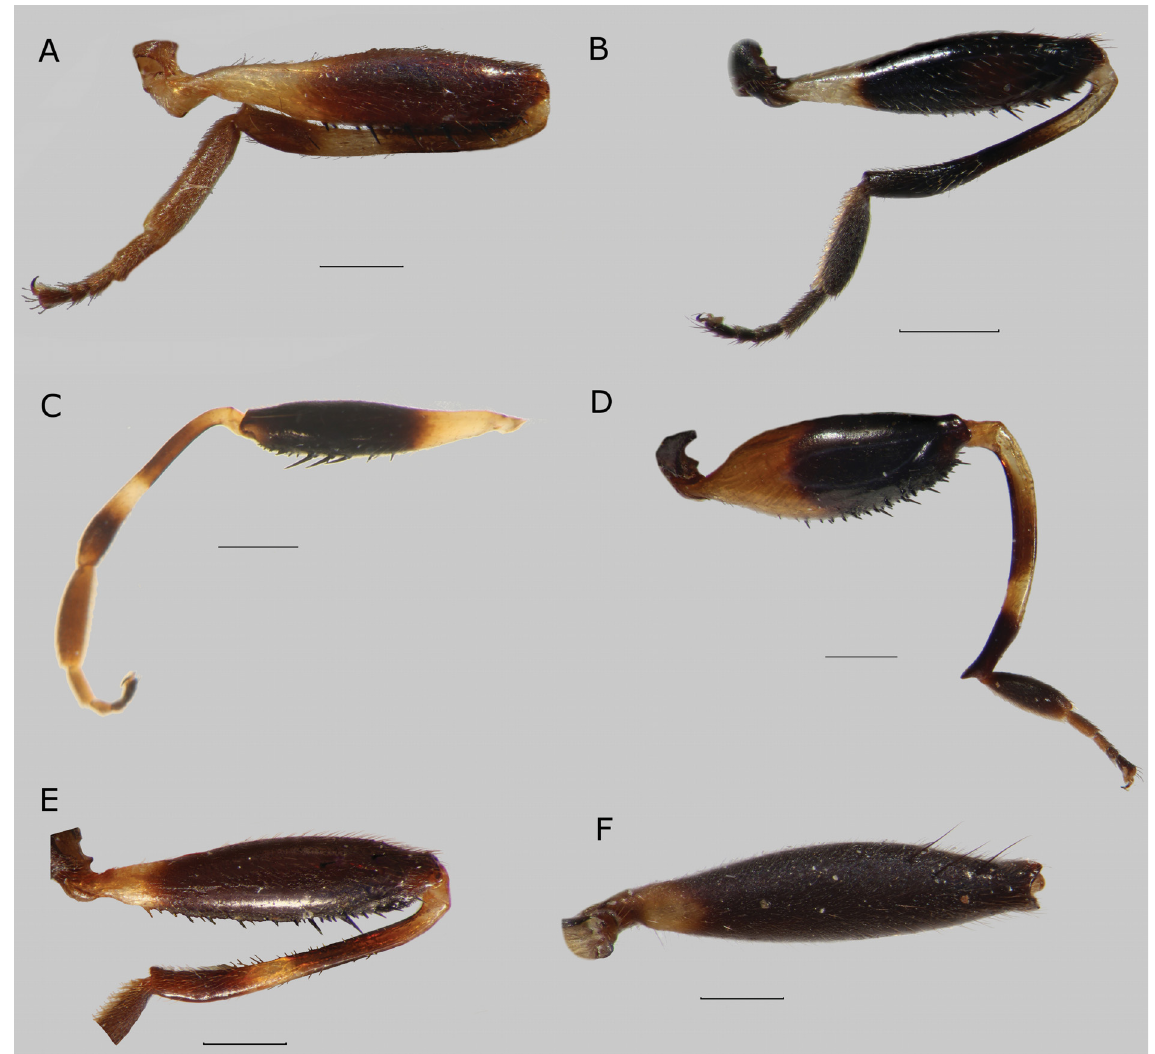
E: note the asymmetrical surstyli, the subbasal lobe on the medial side of surstyli, and the asymmetrical superior lobes.